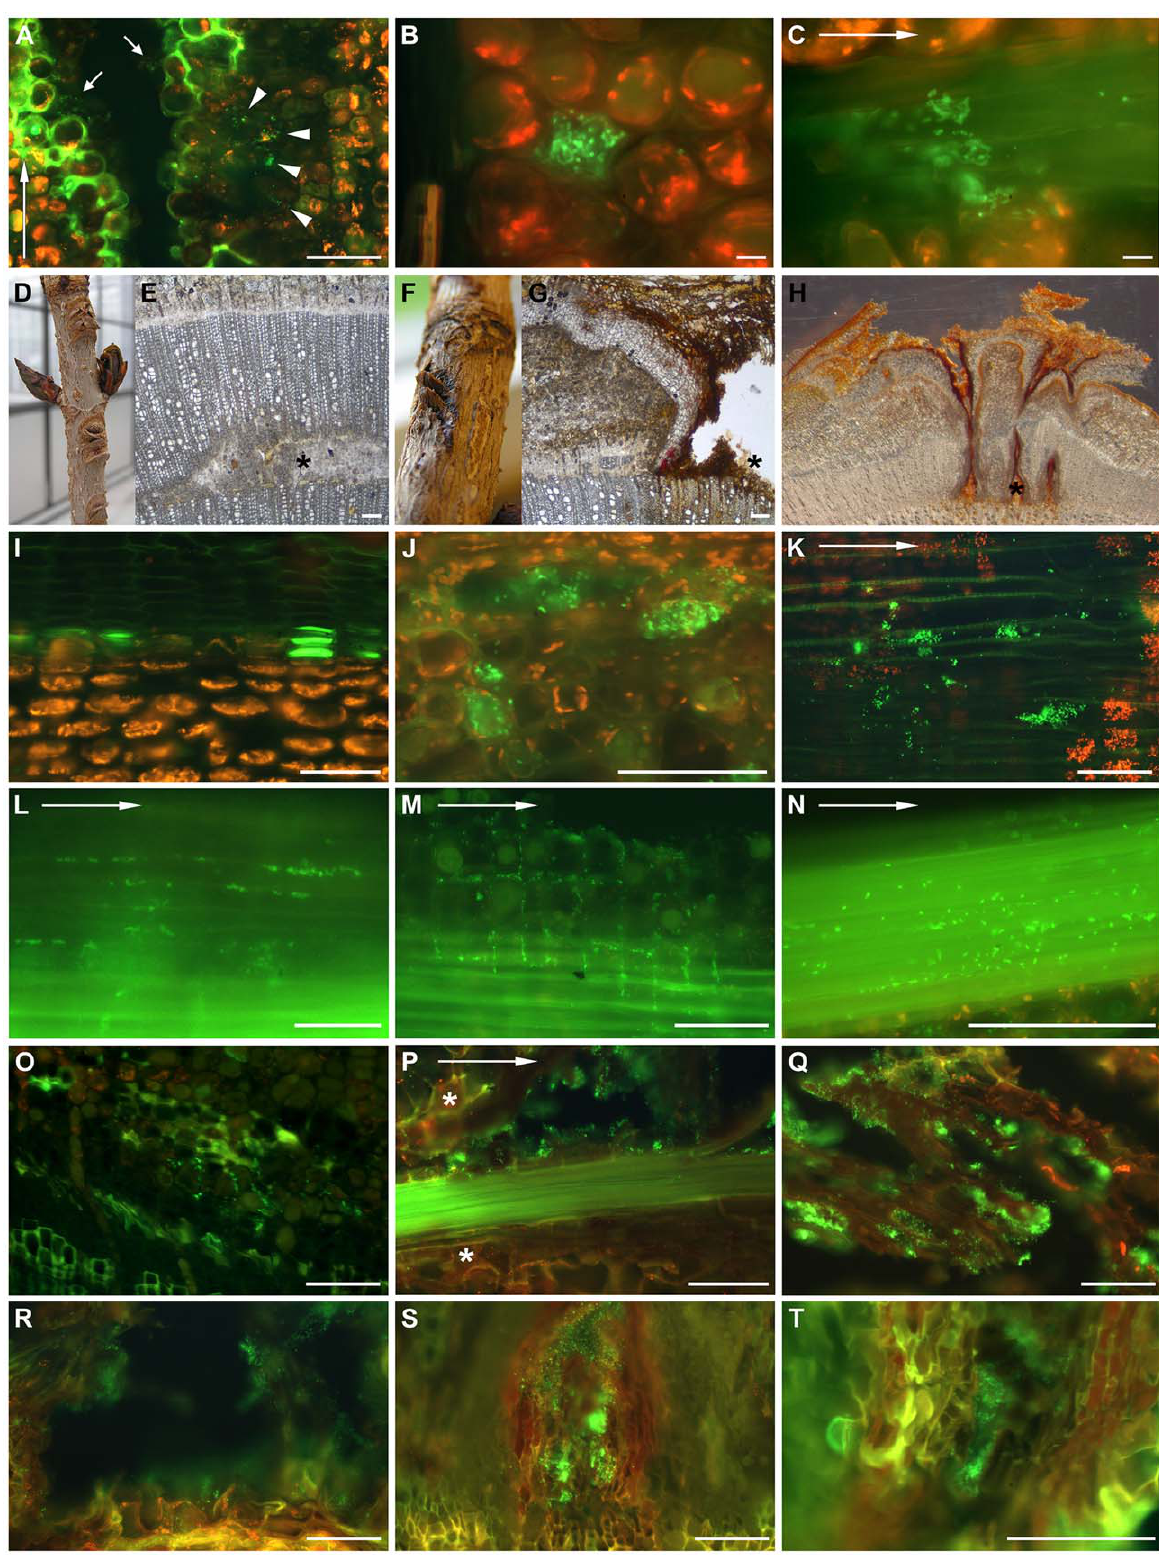
Figure 2. The infection process of P.syringae pv. aesculi and bacterial behaviour inplanta . The infection process up to 18 weeks after inoculation visualized by immunocytochemically labelling of P. syringae pv. aesculi . Arrows in A, C, K, L, M, N and P indicate the longitudinal direction. Scale bars indicate 100 m m in all micrographs except B and C where 10 m m is indicated. (A) Six days after inoculation, when the lining of lignified and suberized cells is prominent, clusters of bacteria are observed in deeper parenchyma tissues (arrowheads) by immunolabelling. Furthermore, bacteria